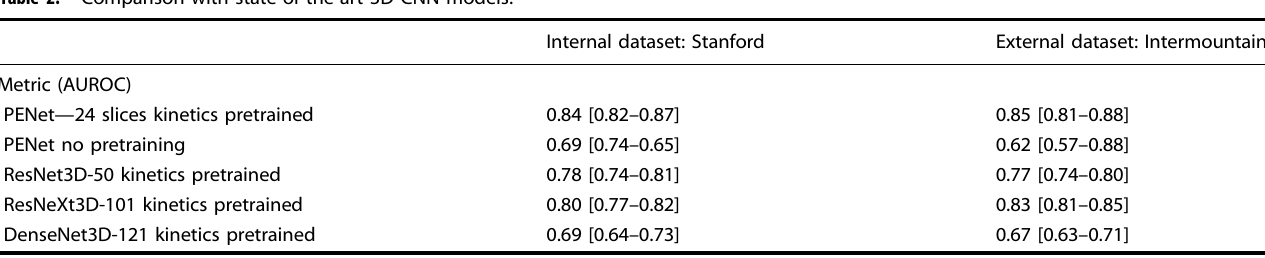
Table 2. Comparison with state-of-the-art 3D CNN models. Internal dataset: Stanford External dataset: Intermountain